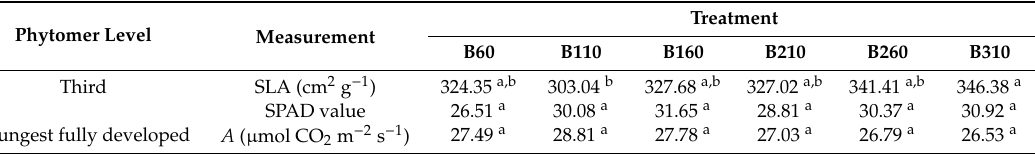
Table 2. Least square means of the final measurement of specific leaf area (SLA), carbon assimilation ( A ) and SPAD at phytomer scale under di ff erent blue photosynthetic flux densities (BPFD). Letters indicate significant di ff erences between treatments ( p <